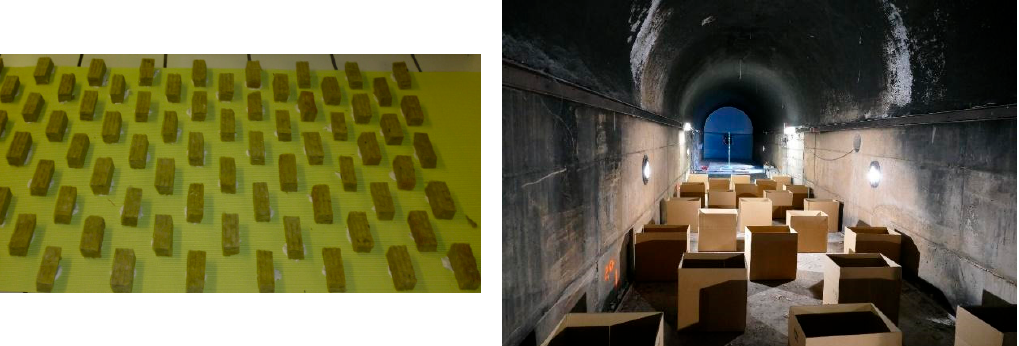
Figure 4. Picture of obstacle distribution for small ( left ) and medium ( right ) scales.